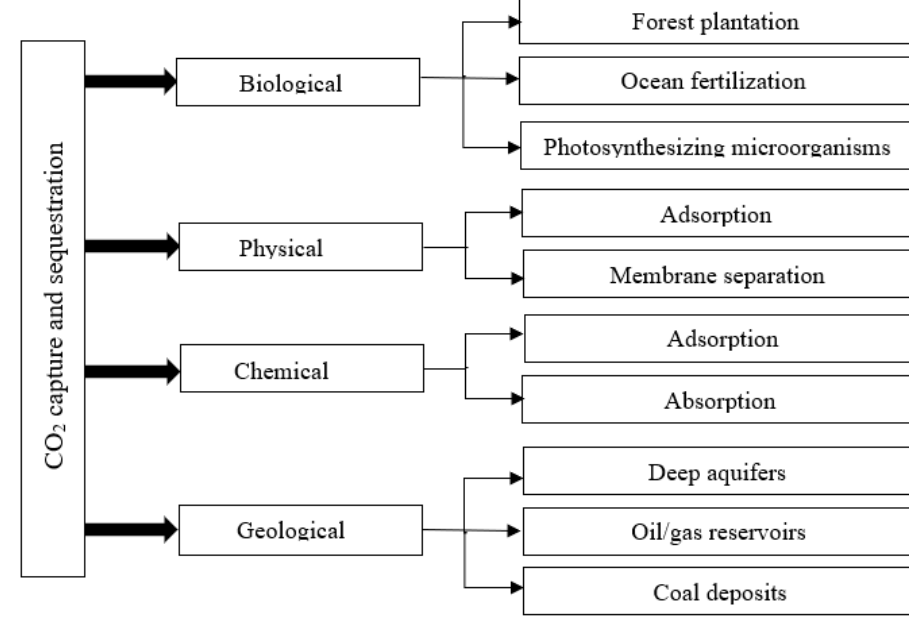
Figure 1. Classification of CO 2 capture and sequestration methods.